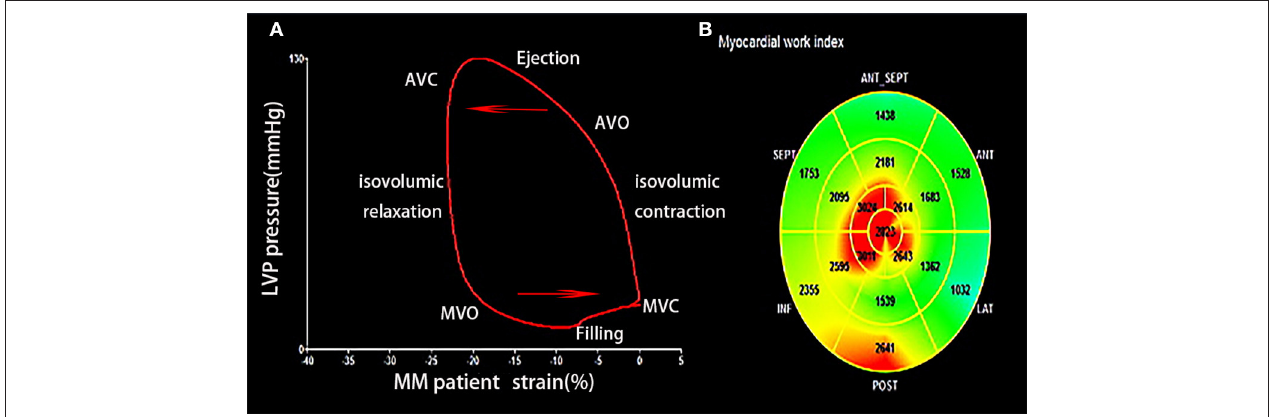
FIGURE 2 | (A) Left ventricular (LV) pressure-strain loops of patient with MM showing LV pressure and GLS change during the cardiac cycle. (B) Segmental GWI of LV. MM, multiple myeloma; GLS, global longitudinal strain; GWI, global work index; AVC, aortic valve closure; AVO, aortic valve opening; MVC, mitral valve closure; MVO, mitral valve